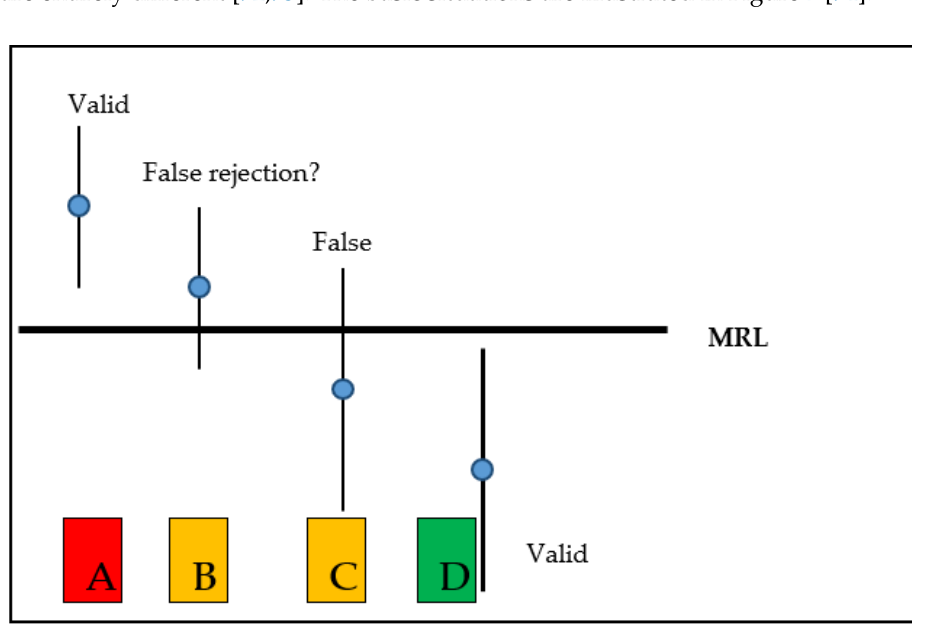
Figure 7. Evaluation of measurement results, taking into consideration of measurement uncertainty for testing compliance with MRLs.